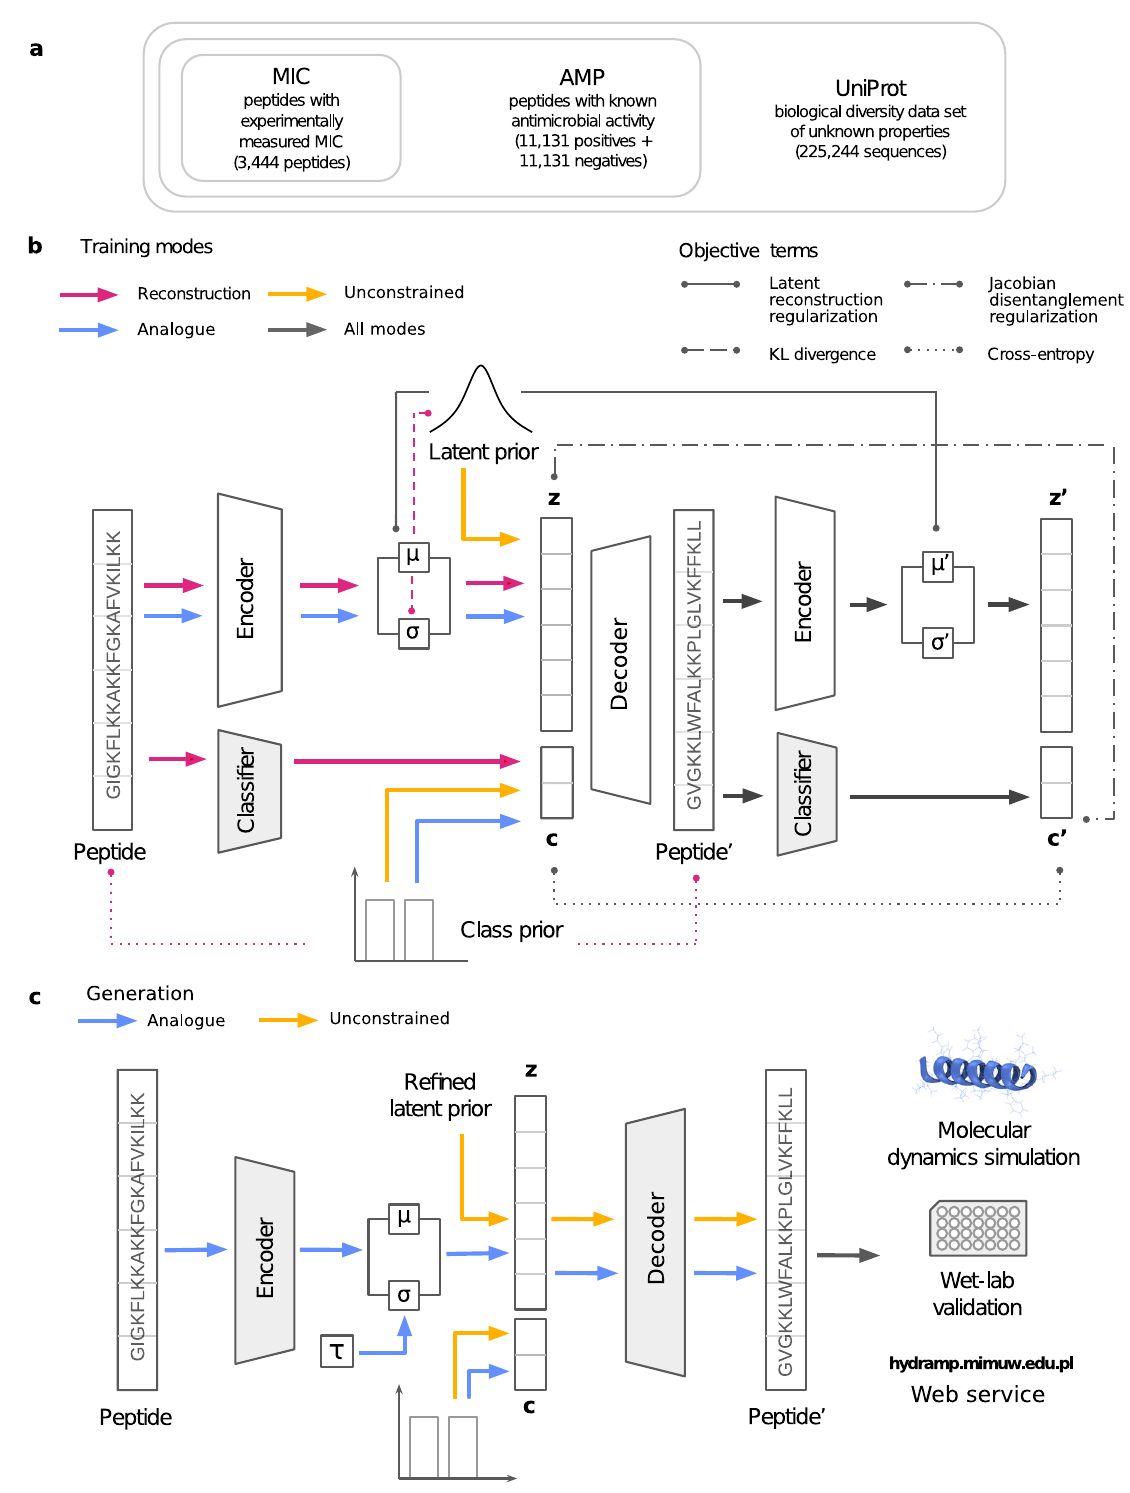
Fig. 1 | HydrAMP architecture and data traversion overview. a Compositional structure of the training data set. b Data fl ow and optimization setup during the training. Colors indicate training modes: reconstruction (pink), uncon- strained (yellow), analogue (blue), and all modes together (grey). The arrows show the path each peptide traverses within a given training mode. Lines connect arguments of different terms of the objective (loss) function, as indicated by line styling: latent reconstruction regularization, Jacobian